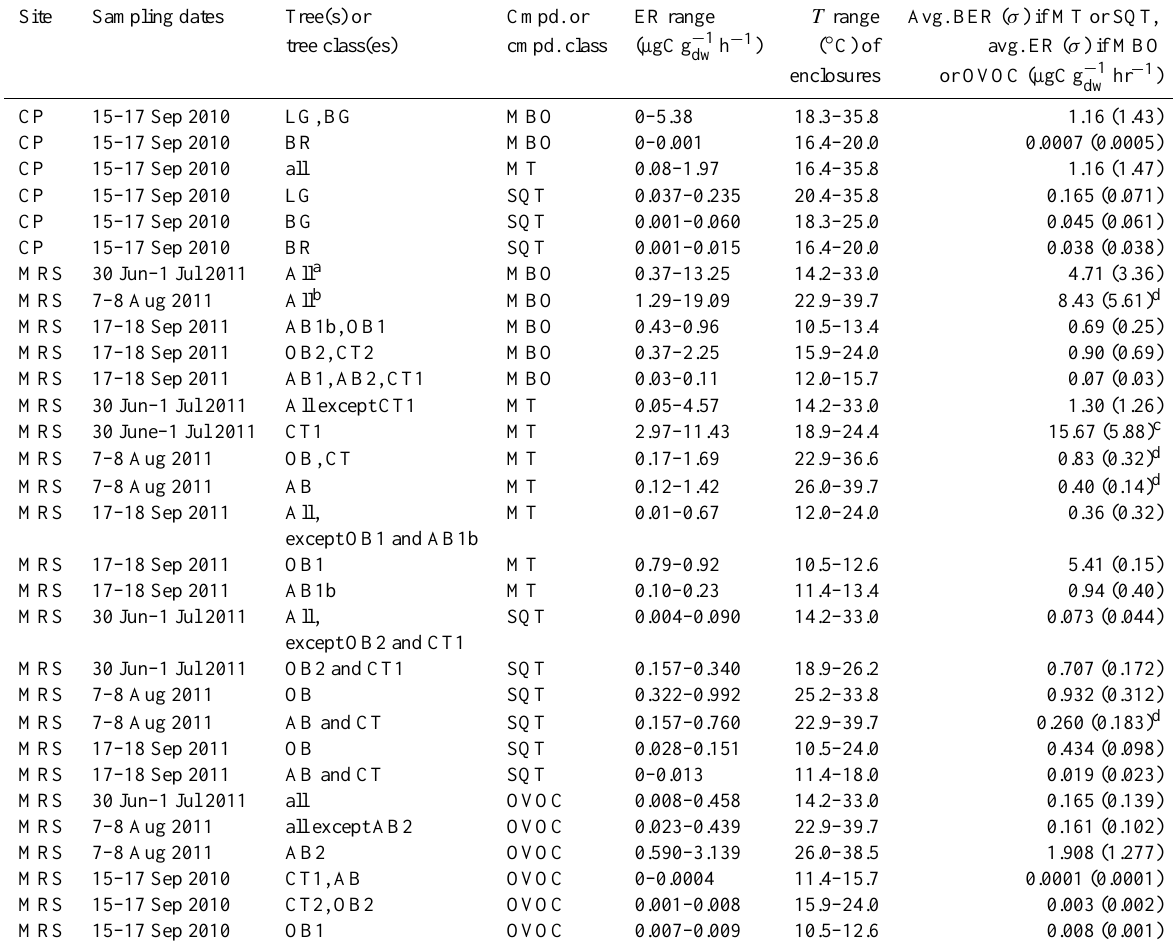
Table 3. ER and temperature ( T ) ranges observed during the CP and MRS sampling visits; results are grouped according to com- pound/compound class and (when appropriate) sample class. Avg. basal ERs (BER) and corresponding standard deviations ( σ ) are presented for MT and SQT; avg. ER and standard deviations are reported for MBO and